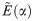
Non-emitting quenching and shifts in FRET transfer efficiency.The observed FRET transfer efficiency E˜(α) is shown when incorporating an additional non-emitting pathway in the donor-acceptor kinetics. For different rates α of non-emitting quenching events, the results show how a reference transfer efficiency E in the case of no quenching is augmented.